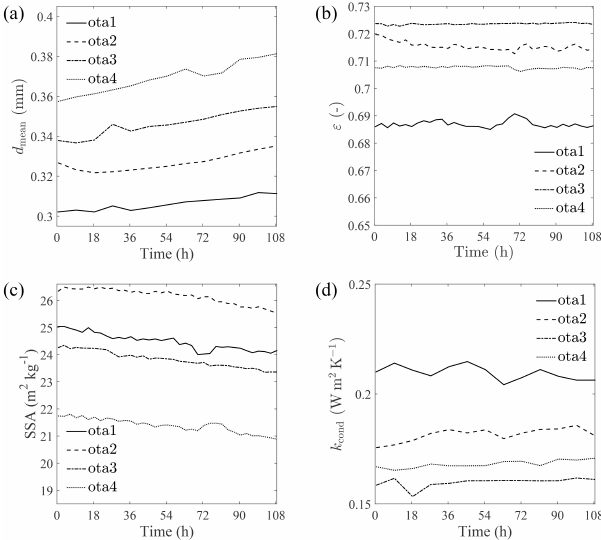
Figure 4. Temporal evolution of (a) the mean pore size, d mean , of the snow samples obtained by an opening size distribution, (b) the porosity, ε , obtained by the triangulated structure surface method, (c) the specific surface area, SSA, of the ice matrix obtained by triangulated structure surface method, and (d) the effective thermal conductivity of the snow sample, k cond , estimated by DPLS. The sizes of the volumes used for the computation of each property are 350 × 350 × 350 voxels (6.3 × 6.3 × 6.3mm 3